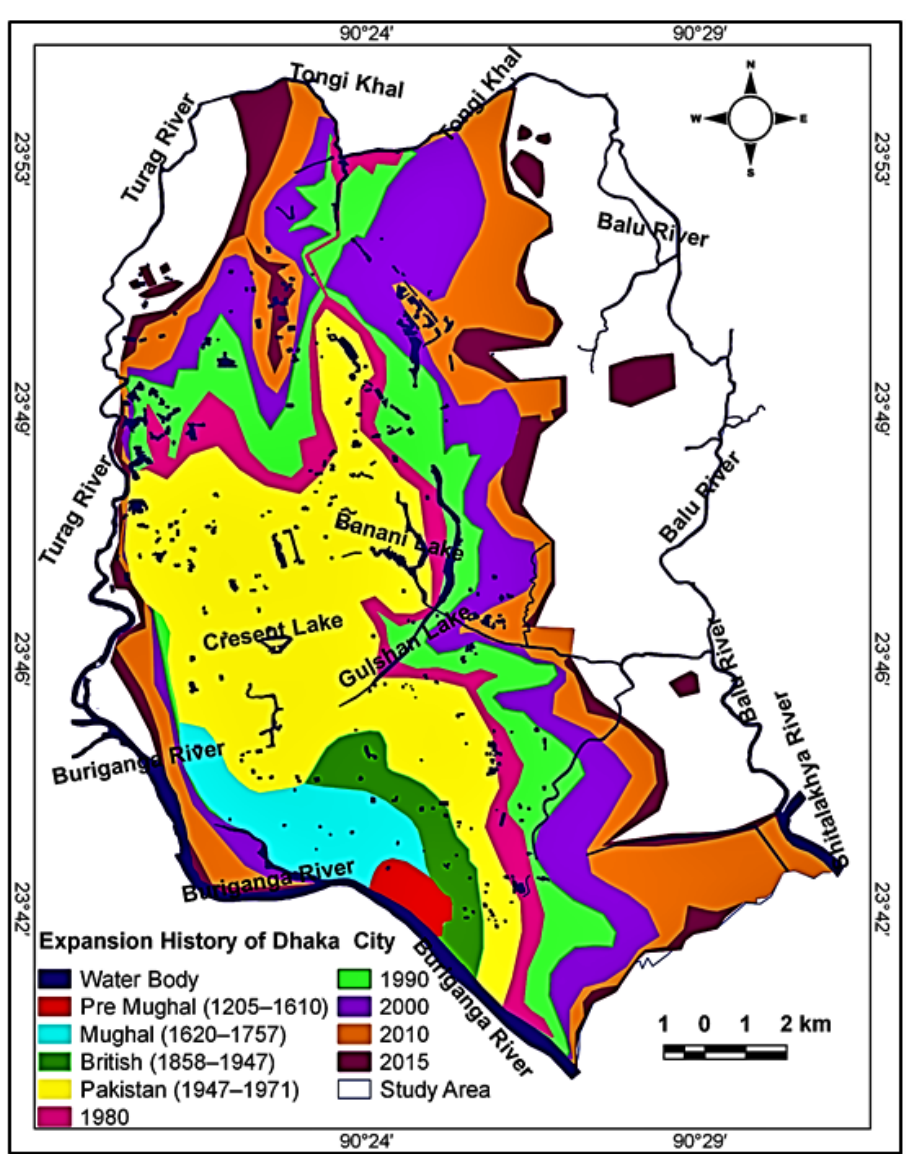
Figure 2. The historical development of Dhaka City at different stages of its growth (modified from [60,67]).